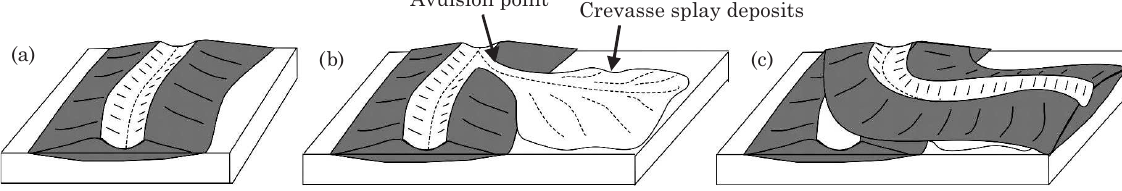
Figure 1. In the avulsion system, the levee of the river is breached (a), and water carrying sediments flows out onto the floodplain, forming crevasse splay deposits (b). Subsequently, a new river channel can be formed; however, the spread sediments can remain in the floodplain (c). Adapted from Assine